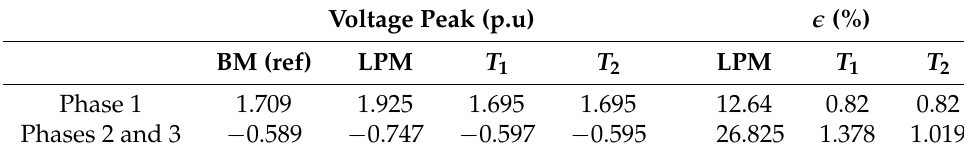
Table 5. Voltage peaks and percentage (cid:101) (%) for scenario 4. Voltage Peak